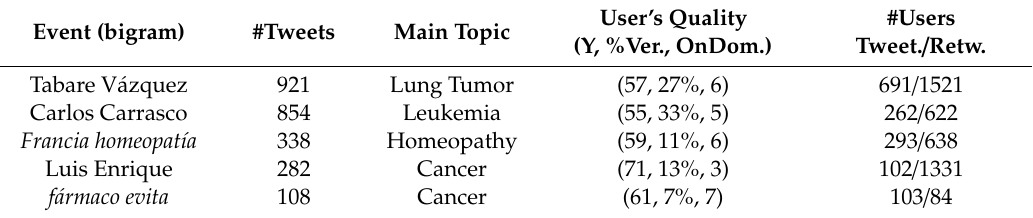
Table 4. Top frequent events (Spanish).